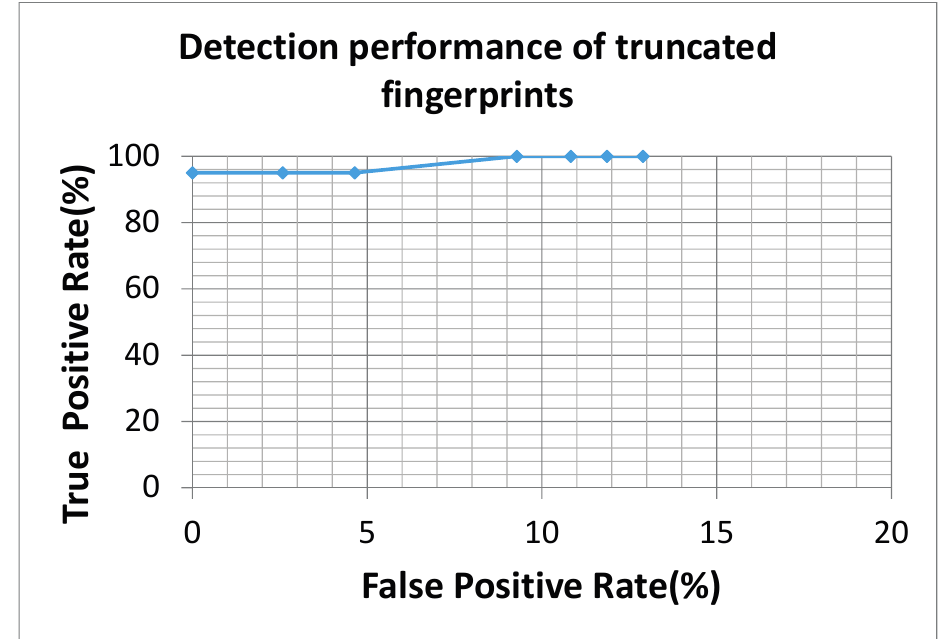
Figure 6. The ROC curve of truncated fingerprint detection is obtained by tuning threshold settings of black-and-white stripe and oriented field change. From left to right, threshold settings were strictly decreased.